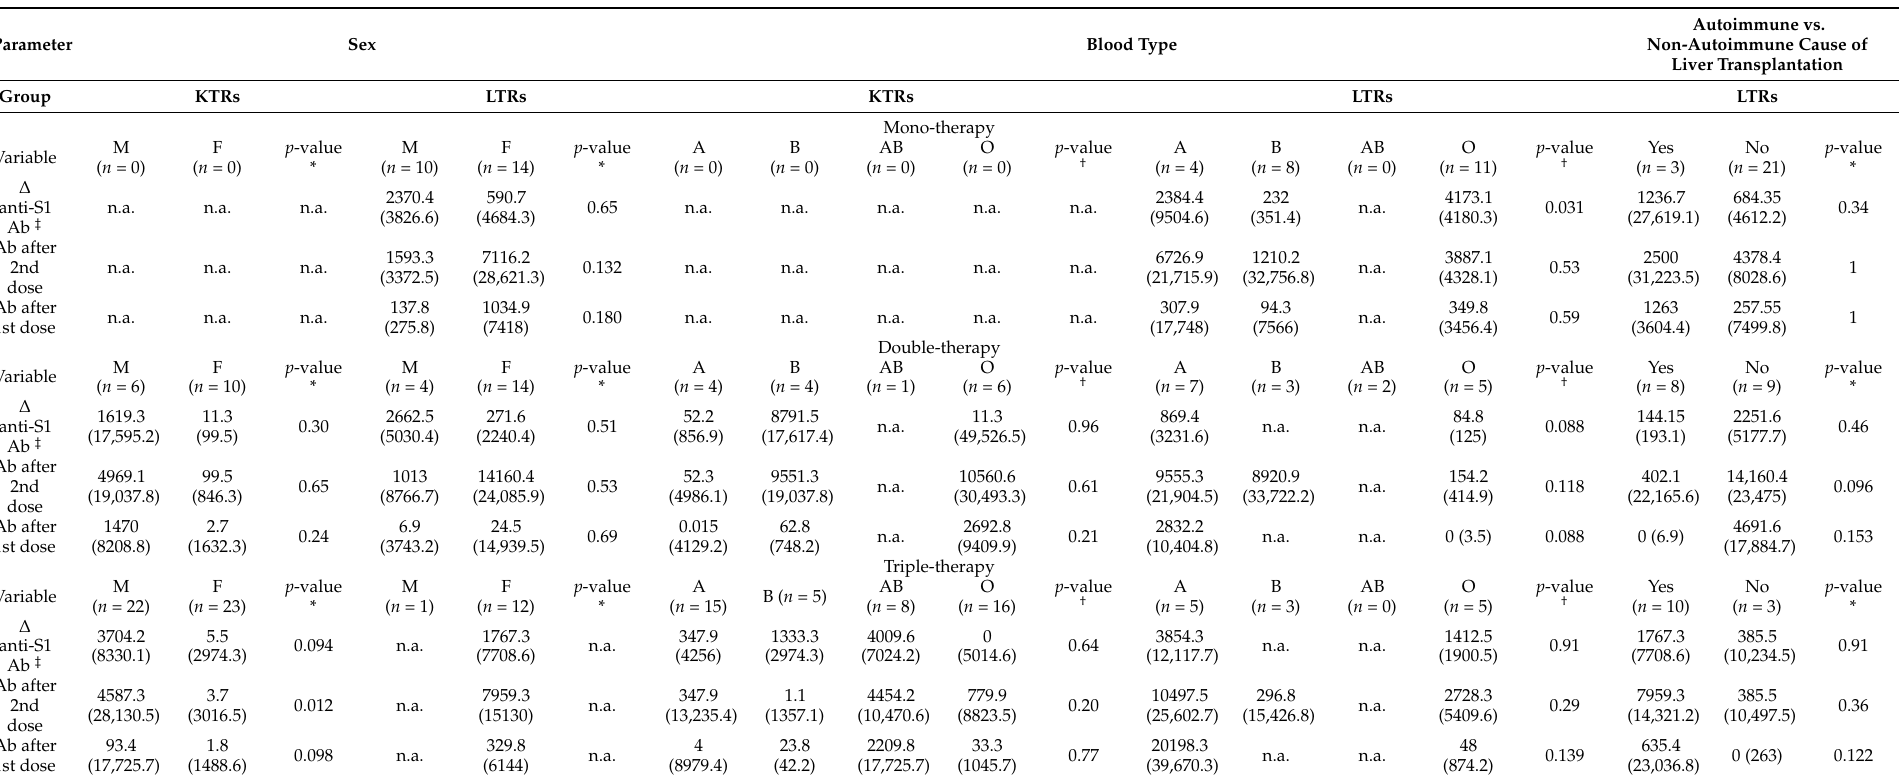
Table A2. Associations of SARS-CoV-2 spike 1 protein Ab concentration (AU/mL) after BNT162b2 vaccination with demographic and clinical variables in KTRs and LTRs depending on the maintenance